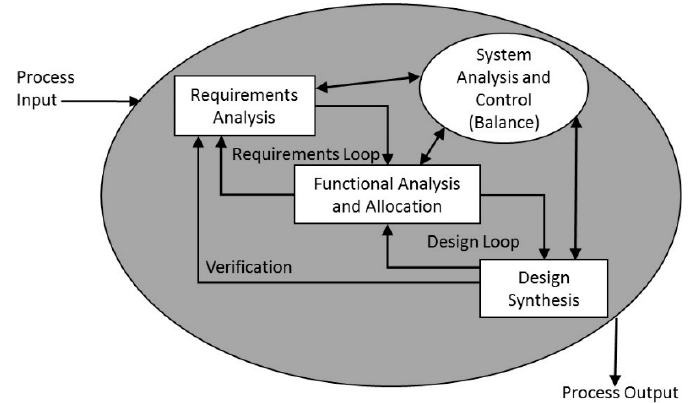
Figure 1. The systems engineering process (SEP).